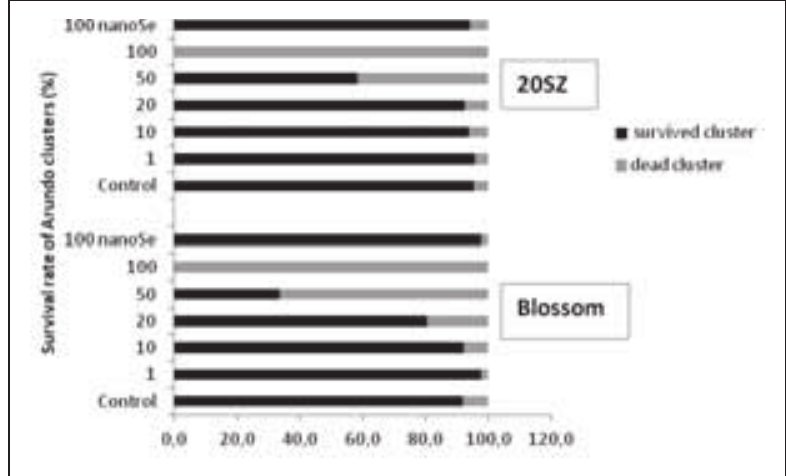
Fig. 1: Survival rate of Blossom and 20SZ Arundo donax embryo-derived germinated clusters treated with 0; 1; 10; 20; 50; 100 mg/L -1 sodium-selenate or red elemental nanoselenium suspension (100 mg/L -1 )